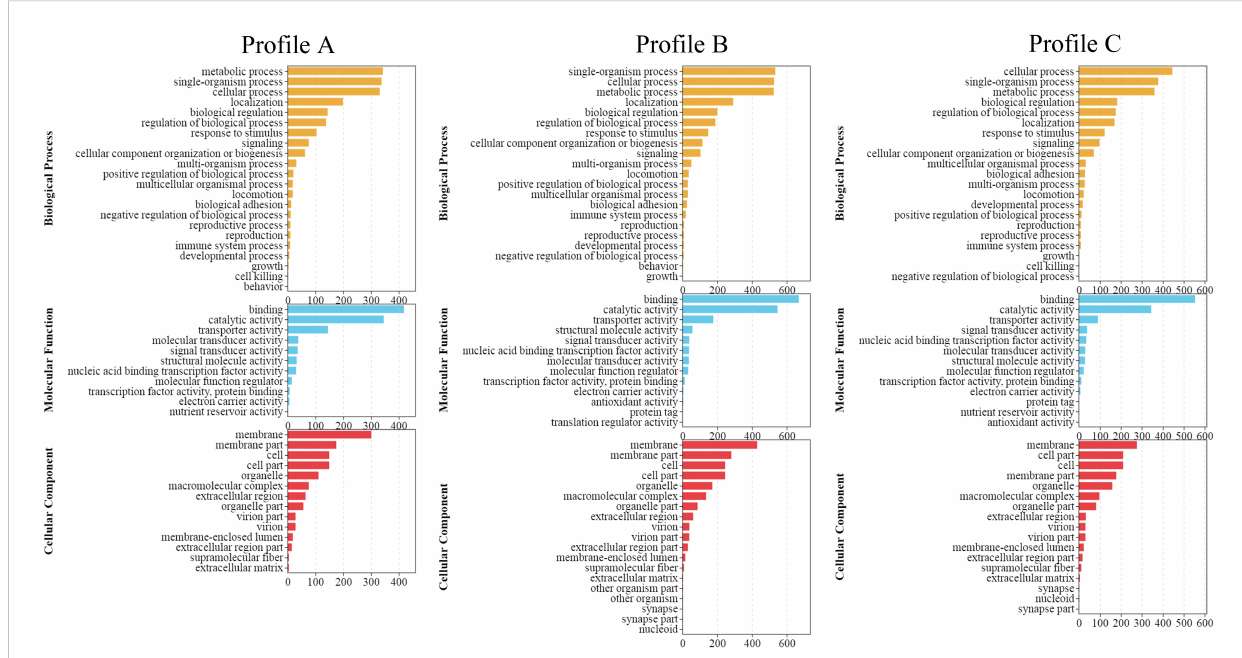
FIGURE 3 Results of GO enrichment analysis of DEGs enrichment under three broad functional categories (n = 4).